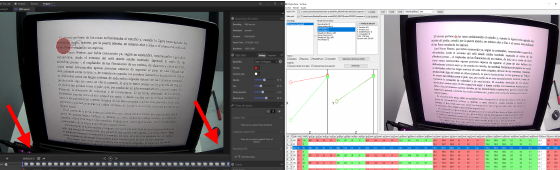
Figure 2: Left: “Event” segmentation of a recording of an iPad reading with the Tobii Pro Lab program. The lower green triangular marks are the start and end of the event. The red circle indicates where the subject is looking at that moment. Right: Analysis of the selected “event” of an iPad reading within the Etracker Parse